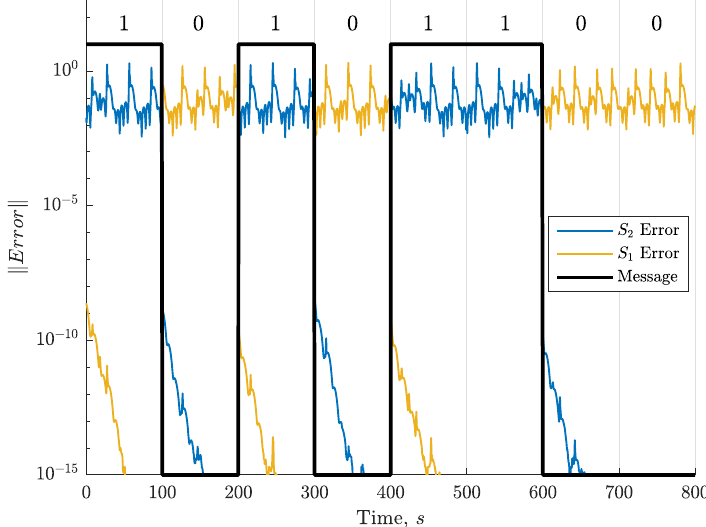
Figure 6. The behavior of synchronization errors at the receiver during transmission of mes- sage